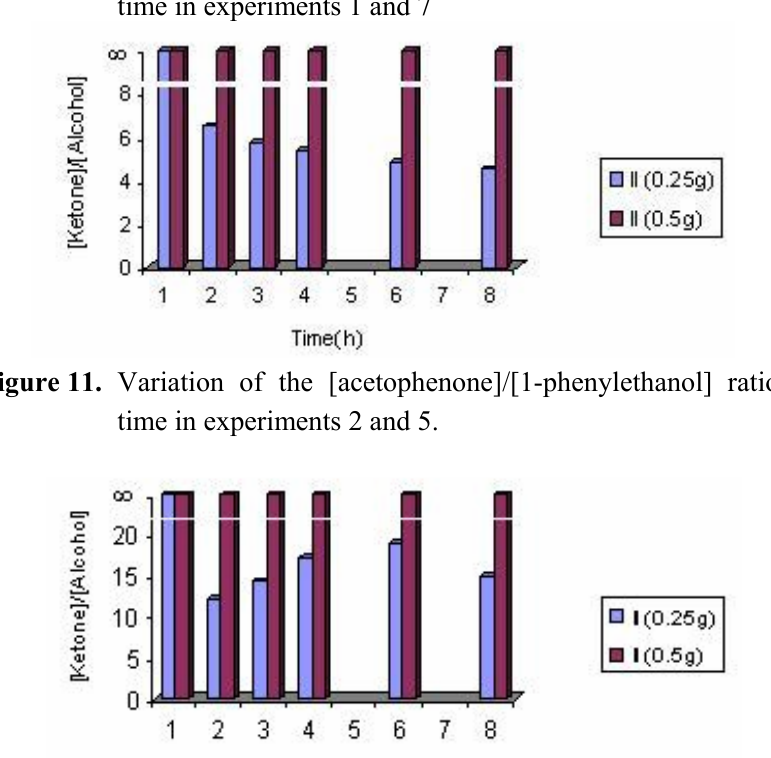
Figure 10. Variation of the [acetophenone]/[1-phenylethanol] ratio vs. time in experiments 1 and 7